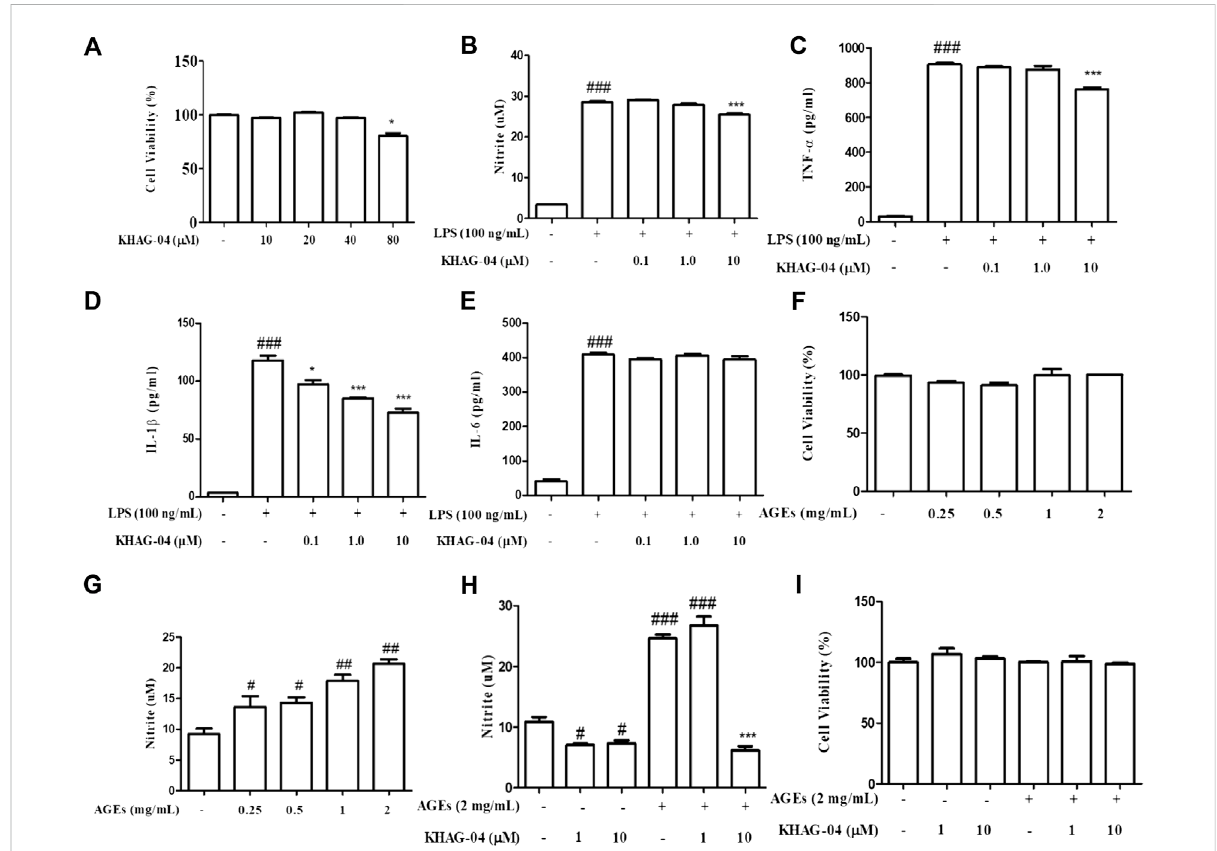
FIGURE 3 Effects of KHAG-04 on LPS- and AGE-induced nitrite productionand pro-in fl ammatory cytokinessecretion in Raw264.7cells. Raw 264.7 cells were pre-treated with 0.1, 1, and 10 μ M of KHAG-04 for 1 h and stimulated with 100 ng/ml of LPS for an additional 23 h. (A) Cell viability in Raw 264.7 cellswas evaluated usingtheMTTassay. (B) Nitrite production wasmeasuredbyusingthenitrite assay. (C – E) The secretion ofcytokines IL-1 β , IL-6,andTNF- α inthesupernatantwasmeasuredaccordingtothemanufacturer ’ sELISAassaykitprotocol. (F) RAW264.7cellswerestimulated with different concentrations of MGO-AGEs (0.25, 0.5, 1, and 2 mg/ml) for 24 h. (G) Nitrite production at different concentrations of AGEs was measuredbyusingthenitriteassay. (H) Cellswerepre-treatedwithKHAG-04(1and10 uM)for1 handstimulatedatindicatedconcentrations(2 mg/ ml) of MGO-AGEs for an additional 23 h for nitrite measurement (I) Cell viability was evaluated in presence of MGO-AGEs and KHAG-04. All data are indicated as mean ± SEM (#, ##, p < 0.05 and ### p < 0.001 vs Control; *, **, ** p < 0.05 and *** p < 0.001 vs 100 ng/ml LPS and 0.5 mg/ml